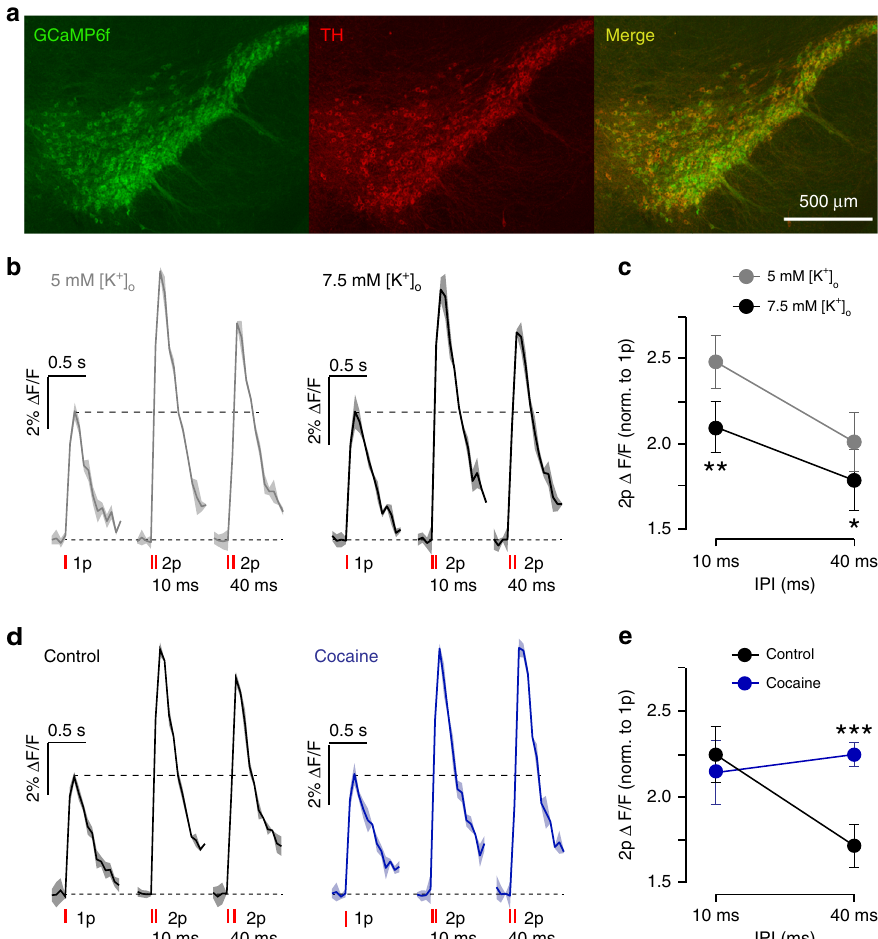
Fig. 9 DATs and [K + ] o gate intracellular Ca 2 + dynamics during paired-pulse stimulations. a Images of VTA and SNc from DAT-Cre:Ai95D mice showing GCaMP6f eGFP expression (green) in TH-positive neurons (red). b , d Examples of Ca 2 + -imaging responses (changes to GCaMP6f fl uorescence, Δ F/F) (mean ± SEM from duplicate) in DA axon population imaged in CPu in response to single or paired electrical pulses at IPI of 10 and 40 ms in ( b ) 5 mM [K + ] o (grey) or 7.5 mM [K + ] o (black), or ( d ) in control conditions (black) or the presence of cocaine (5 µ M) (blue). Data are rescaled to 1p in each condition to control for photobleaching. c , e Mean peak values for GCaMP6f Δ F/F evoked by 2 pulses vs IPI. Data are normalised to value for 1 pulse ( N = 5 animals). Two ‐ way ANOVA with Fishers LSD test for post hoc comparisons: * P < 0.05, ** P < 0.01, *** P < 0.001. DH β E (1 µ M) is present throughout. Error bars are ± SEM. Source data are provided as a Source Data fi